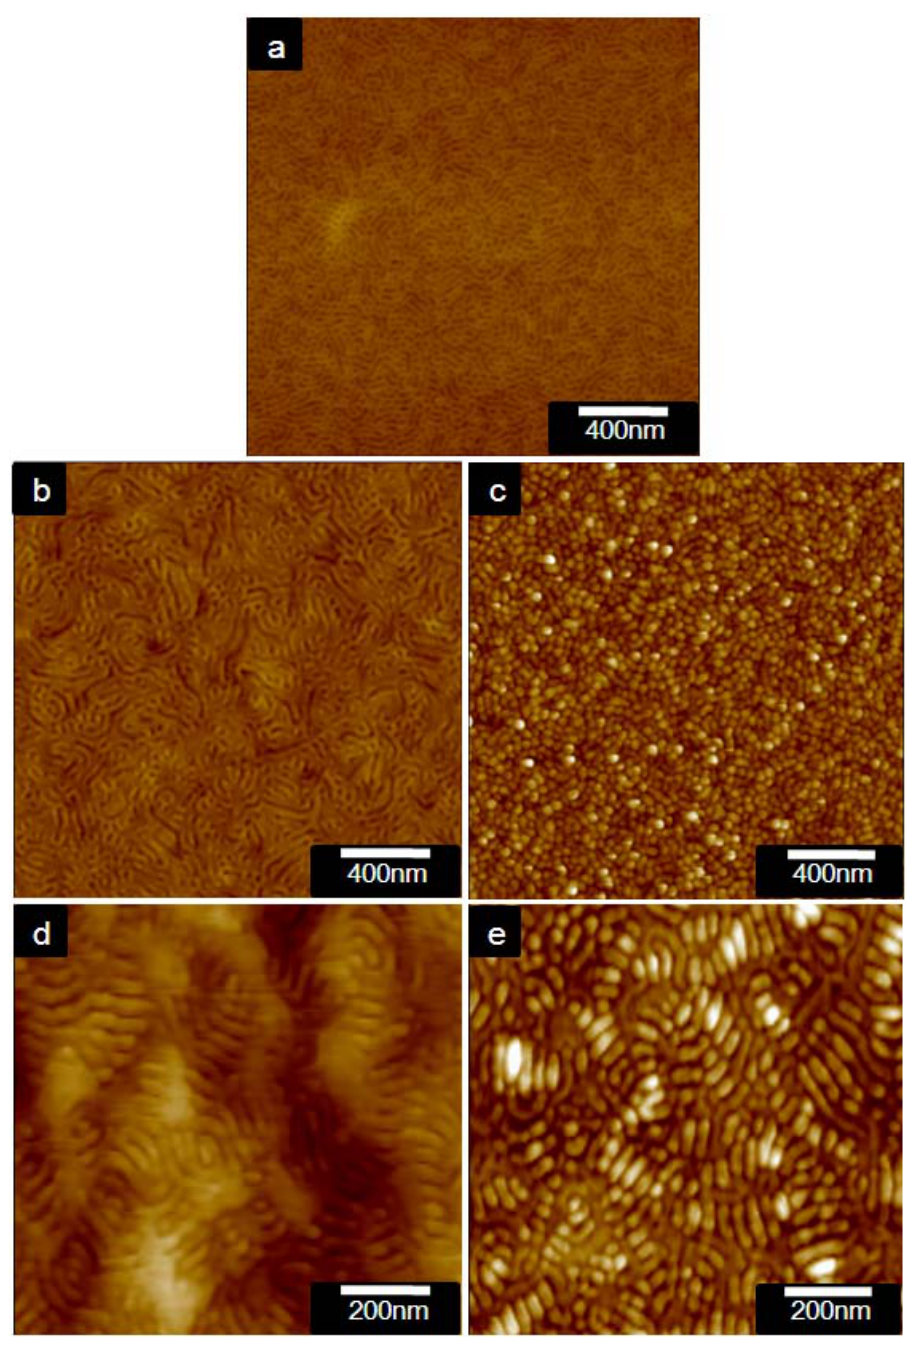
Figure S1 . Height contrast AFM images of the surfaces of (a) neat PS- b -PEO film; -TiO film containing 10 vol% inorganic precursors; (c) identical film (b) PS- b -PEO/SiO 2 2 in (b) after removing the BCP templates; (d) PS- b -PEO/SiO 20 vol% inorganic precursors; (e) identical film in (d) after removing the BCP templates. The hybrid films were prepared from spin coating dioxane solutions. Ti/Si mass ratio is